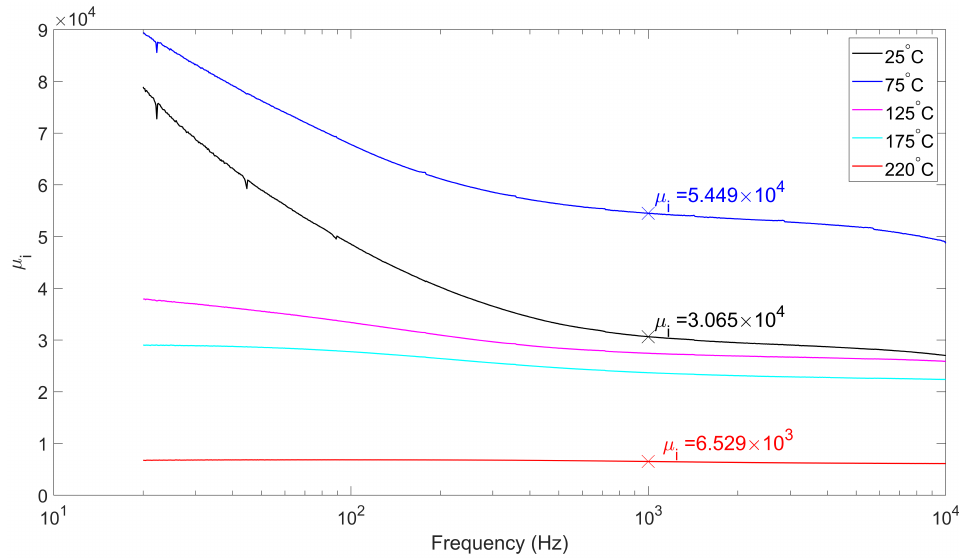
Figure 8. Initial permeability at different temperatures. The permeability at 1kHz is marked by